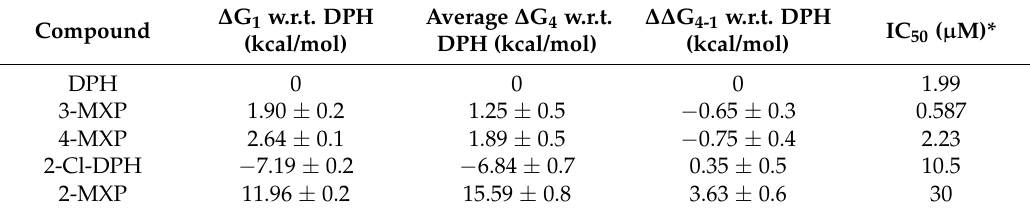
Table 1. Calculated binding free energy change ( ∆∆ G, kcal/mol) of the substituted analogs against DPH and their experimental IC 50 values ( µ M)* from Wallach et al., 2016. ∆ G 1 represents the unbound solvent (ligand in water) state while ∆ G 4 represents the bound (protein-ligand complex in water) state. ∆ G 1 w.r.t. Compound